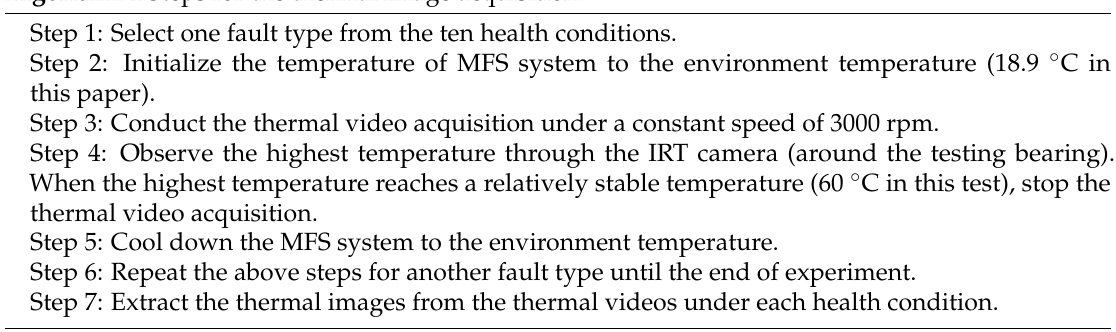
Algorithm 1 Steps for the thermal image acquisition.